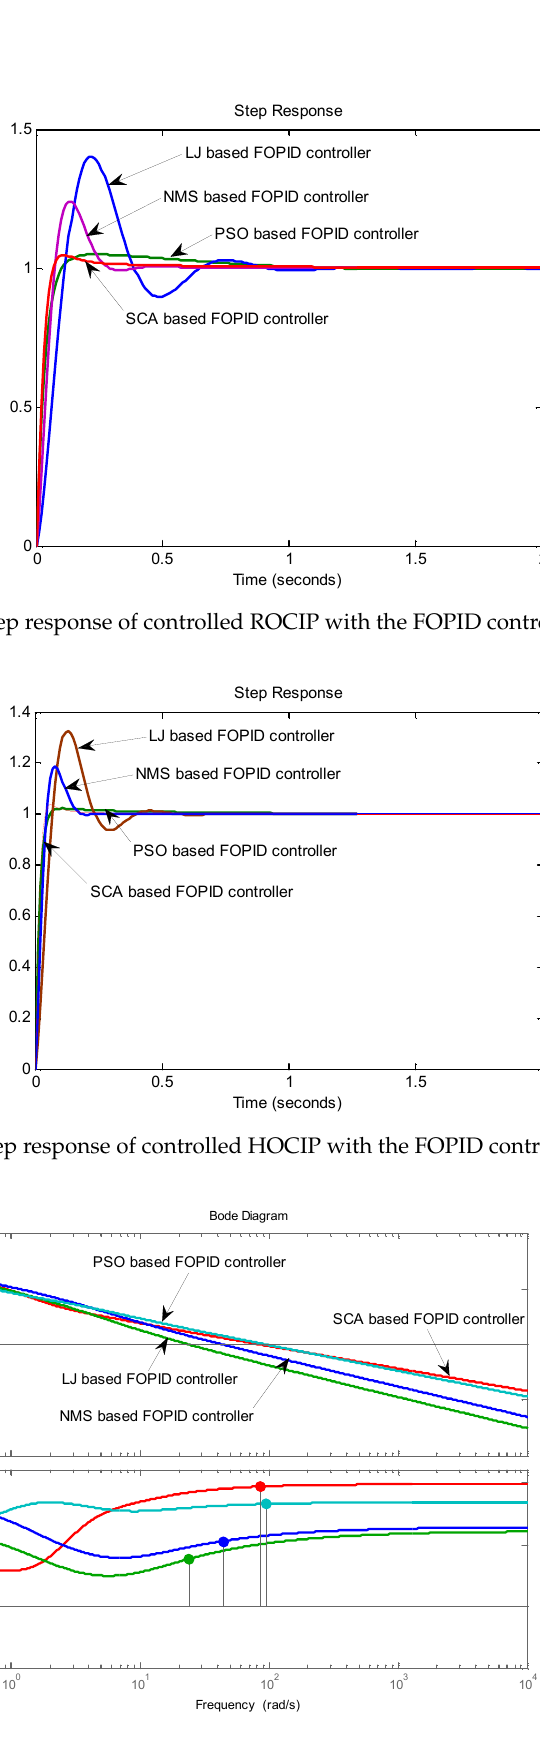
Figure 14. Bode response of controlled ROCIP with FOPID